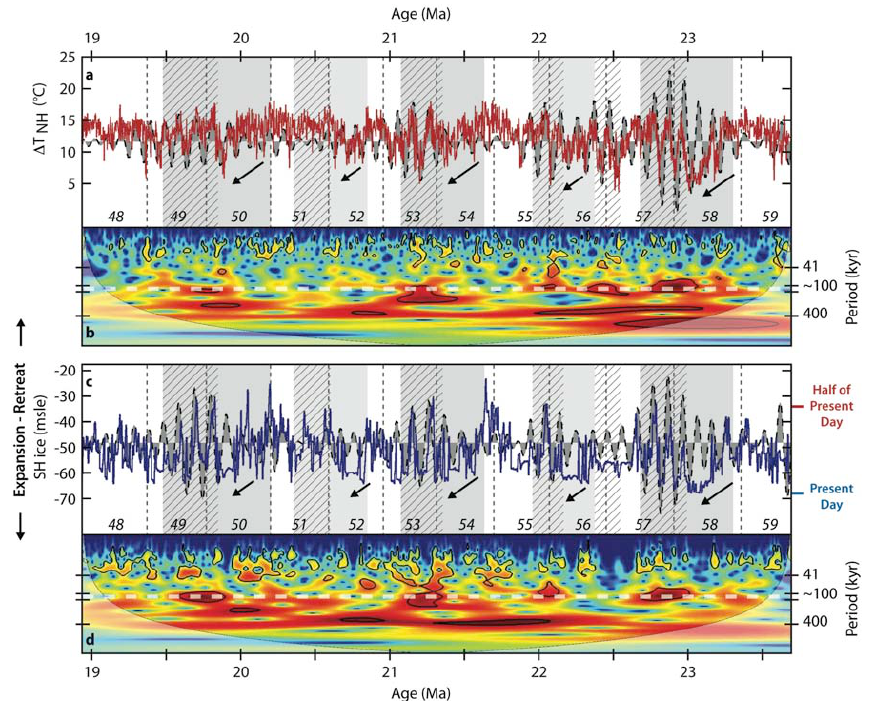
Fig. 6. 1-D inverse modelling output (De Boer et al., 2010). (a) Northern Hemisphere (40–80 ◦ latitude) annual average air temperature, with ∼ 100kyr filtered component ( f : 10.0, bw: 2.0) (Paillard et al., 1996) depicted in the background. (b) Wavelet analysis (Grinsted et al., 2004) of NH temperature variability. Data processed as in Fig. 5. (c) Antarctic ice, with ∼ 100kyr filtered component ( f : 10.0, bw: 2.0) (Paillard et al., 1996) depicted in the background. (d) Wavelet analysis (Grinsted et al., 2004) of Southern Hemisphere (Antarctic) ice variability (in meter sea level equivalent). Data processed as in Fig. 5. White dashed lines indicate the ∼ 100kyr period. Vertical dashed lines and numbers in italic represent the 400kyr cycle numbers (Wade and P¨alike, 2004).